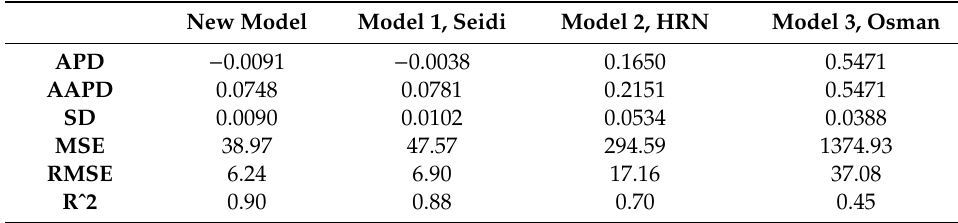
Table 12. A comparison of six di ff erent measures of accuracy corresponding to di ff erent models using the production data set of the 192 / 64 inch choke